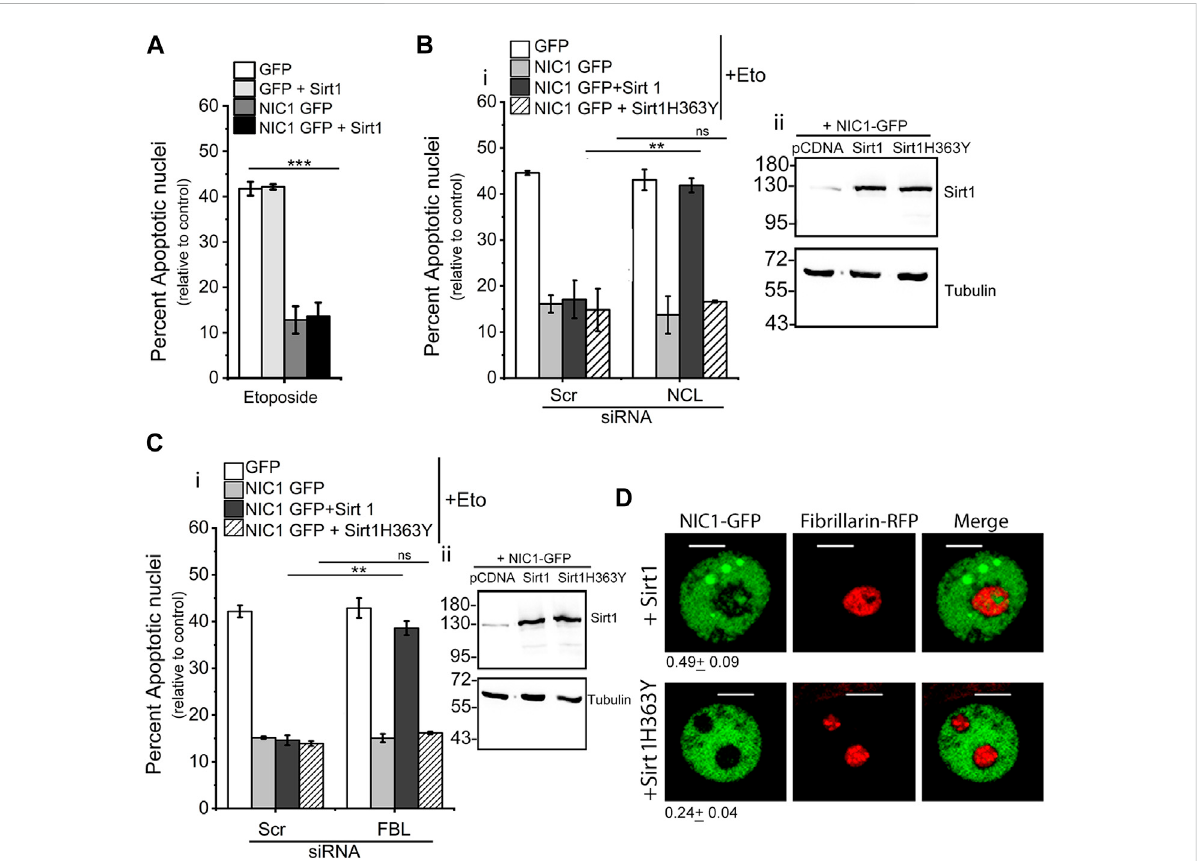
FIGURE 2 Co-expressionofSirt1butnotSirt1H363YwithNIC1promoteslocalizationtothenucleolus. (A) PercentapoptoticnucleiinHEKcellsexpressing NIC1-GFP, NIC1-GFP + Sirtuin1 (Sirt1), GFP, or GFP + Sirt1 cultured with etoposide (10 µM) in medium containing 2% FBS for 48 h (B,C) Percent apoptotic nuclei in HEK cells expressing NIC1-GFP, NIC1-GFP + Sirt1, NIC1-GFP + Sirt1H363Y or GFP cultured with etoposide (10 µM) in medium containing2%FBSfor48 h.HEKcellspre-treatedwithsiRNAtoNCL (Bi) ,FBL (Ci) ,orscrambledcontrolfor48 hweretransfectedwithindicated plasmids and cultured for 24 h before etoposide treatment. (Bii,C-ii) Immunoblots probed for Sirt1 and Tubulin in cell lysates from cells co- transfected with Sirt1, Sirt1H363Y or control pcDNA with NIC1-GFP and cultured for 48 h. Immunoblots are representative of three independent experiments. (D) Representative confocal images of HEK cells co-expressing NIC1-GFP, Fibrillarin RFP and Sirt1 or Sirt1H363Y imaged 24 h post- transfection. Images are representative of at least 40 cells across two independent experiments. 0.49 ± 0.09 (NIC1-GFP + Sirt1) and 0.24 ± 0.04 (NIC1-GFP + Sirt1H363Y) show the relative NIC1 levels in the nucleolus as compared to the nucleoplasm. Data plotted as mean ± S.D. of three independent experiments. *** and ** show signi fi cant difference with p -value ≤ 0.001 and ≤ 0.01, respectively, and ns shows non-signi fi cant difference examined using the unpaired student ’ s